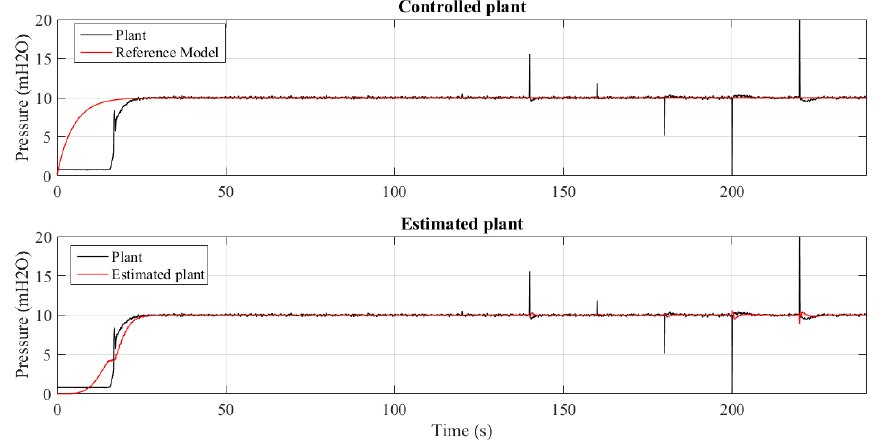
Figure 16. System using the MSE criterion subjected to outliers at intervals of every 20 s.